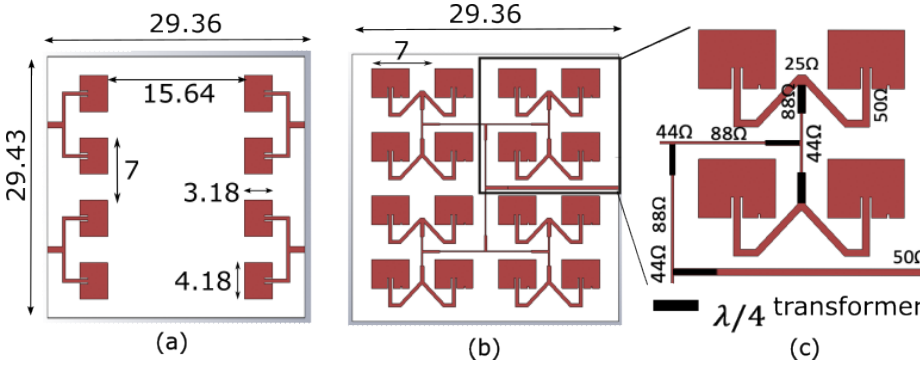
Figure 4. Dimensions of the final ( a ) TX and ( b ) RX antennas optimized in the band of 24–24.25 GHz. ( c ) The upper half of the RX antenna showing detailed design parameters, including the impedances of each line and λ /2